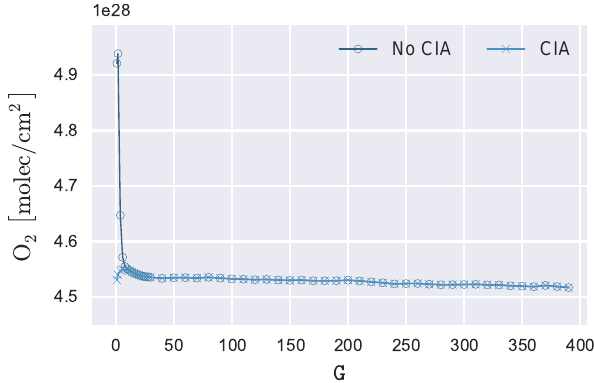
Figure 9. Retrieved total column of O 2 with respect to the number of guiding points G without (no CIA) and with modeling of the collision-induced absorption (CIA).